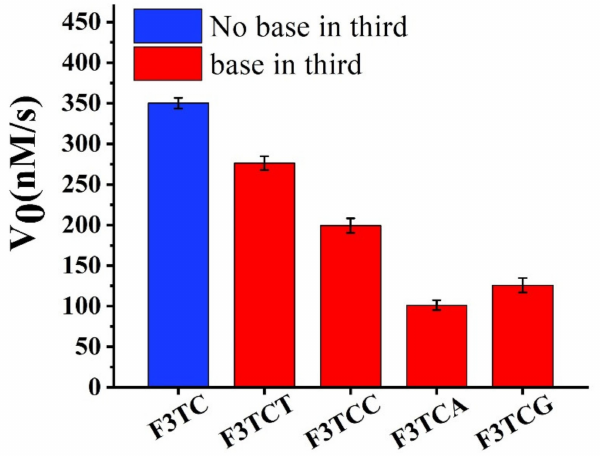
Figure 5. Catalytic performance of G-quadruplexes with F3TC and F3TCN (N = dT, dC, dA and